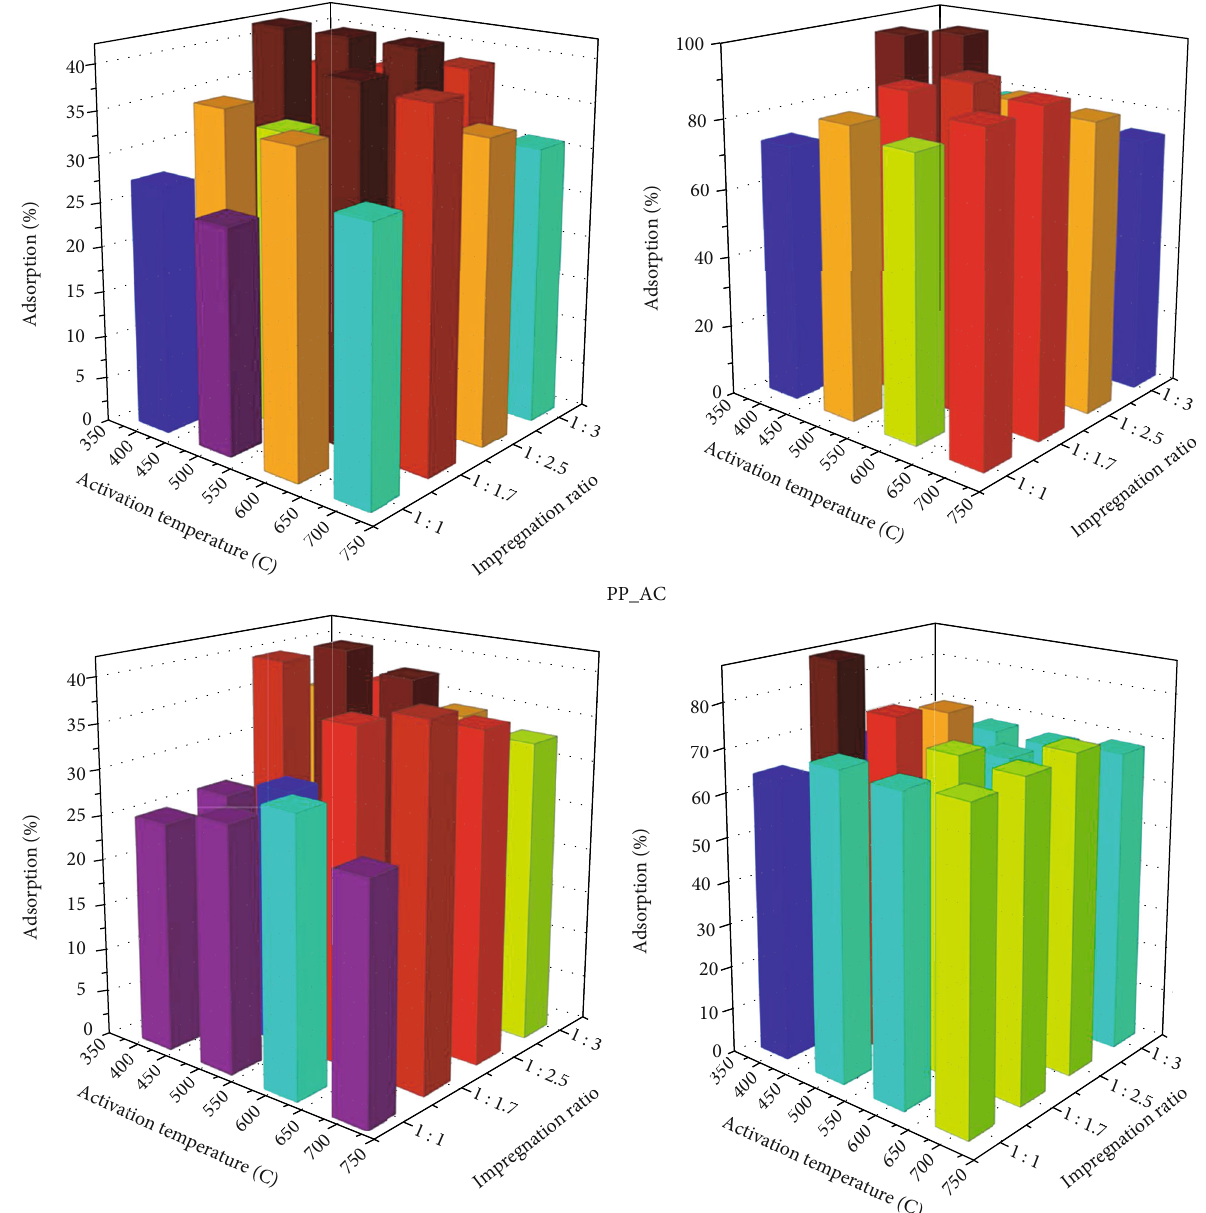
Figure 4: Ammonia (a) and gasoline (b) adsorption of the prepared activated